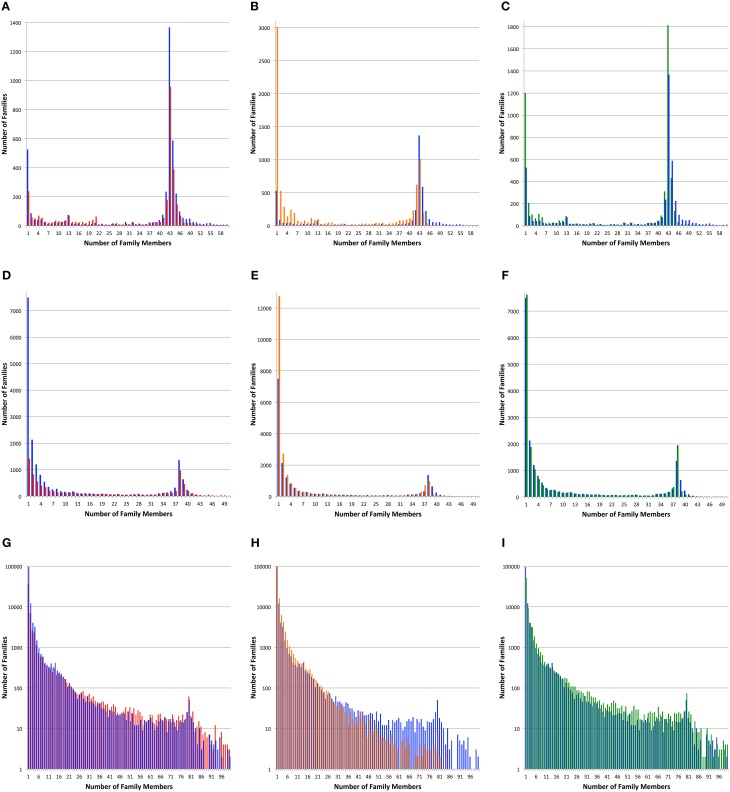
Protein family sizes. Histograms depict the number of protein families vs. the number of family members. Protein families were generated with PATtyFams (blue bars), FIGfams (red bars), kClust (orange bars), and OrthoMCL (green bars). The first row (A–C) shows families generated for the 43 Brucella genomes. The second row (D–F) shows families generated for the 38 Escherichia genomes. The third row shows families generated for the 80 diverse genomes. Note that the scale of the Y-axis changes and is shown in log-scale for (G–I).